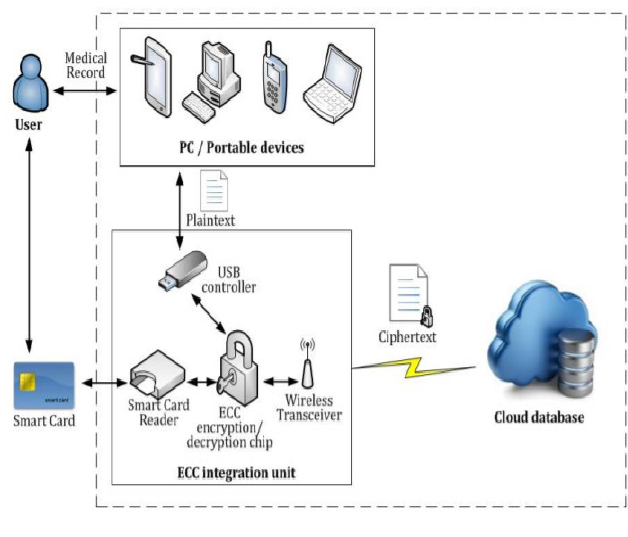
Figure (2). An ECC based e-health system architecture